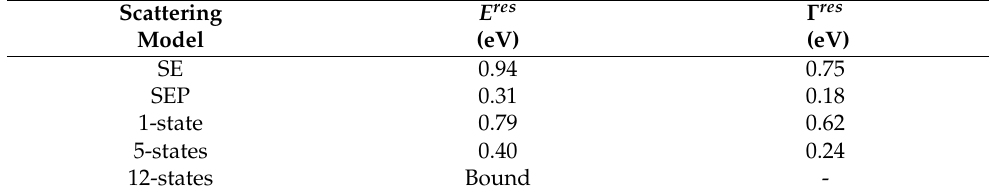
Table 3. E res and Γ res values in different scattering models for 2 A 1 scattering symmetry.